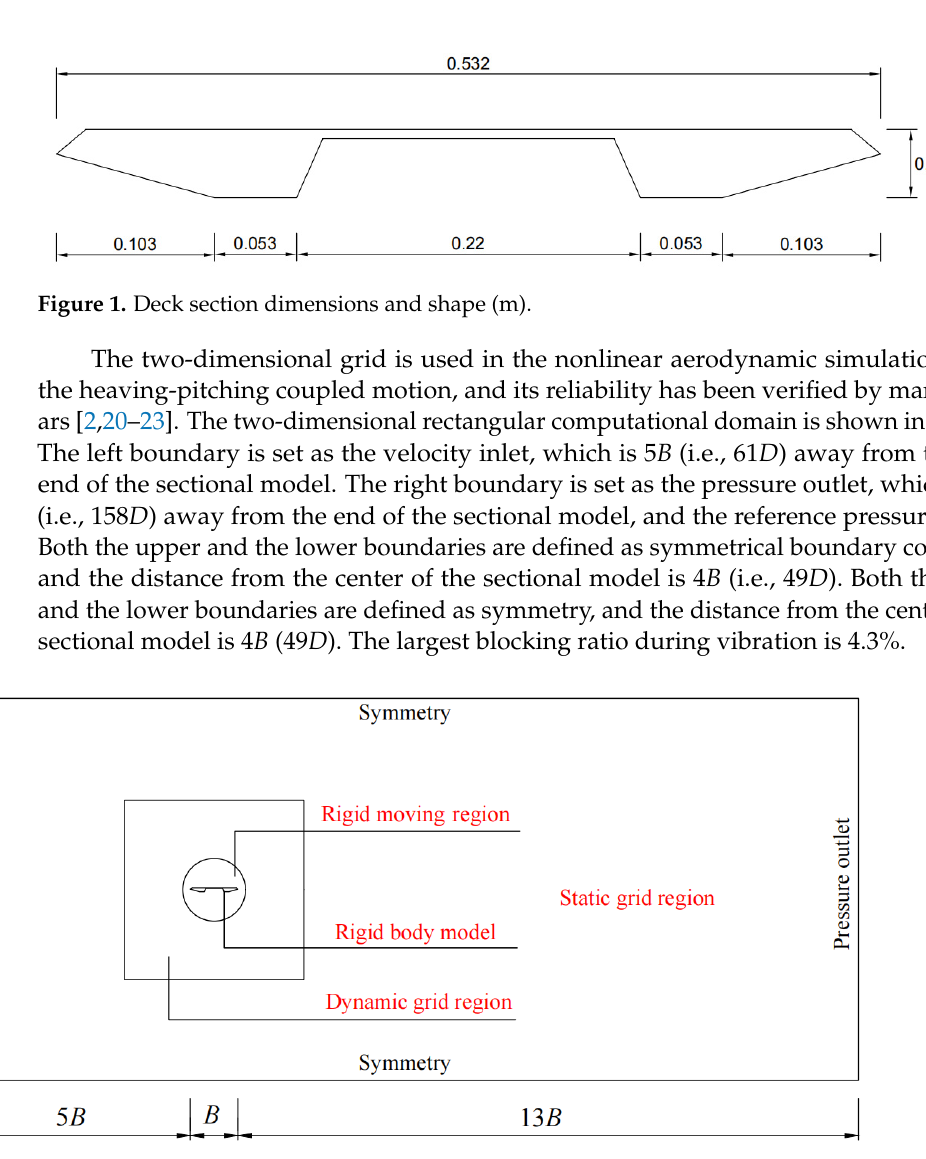
Figure 2. Schematic diagram of model computing domain.